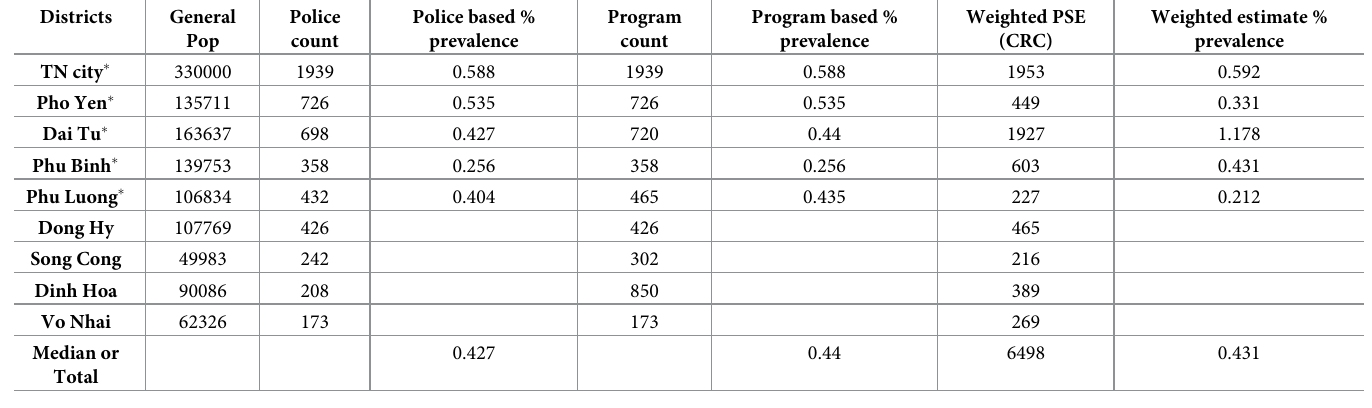
Table 3. Surveyed districts and PS estimates for all 9 districts